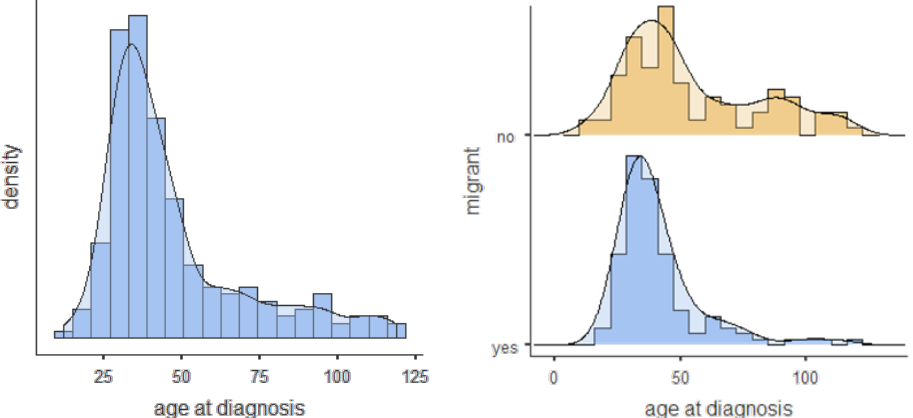
Figure 1. Age at diagnosis distribution histogram and density plot for total sample and split by migrant status.